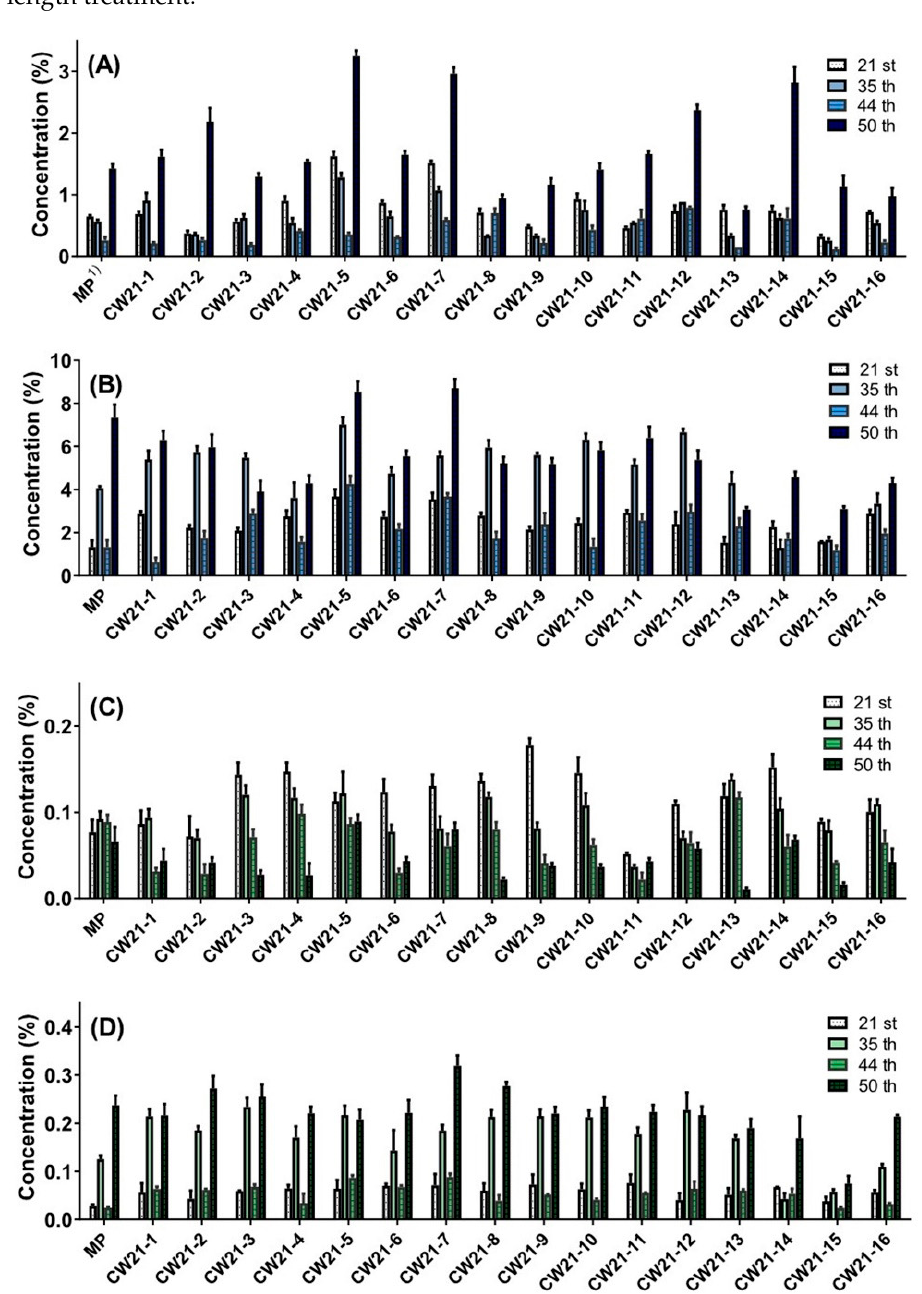
Figure 4. Cannabinoid content by strain and date. ( A ) CBD + CBDA of leaf, ( B ) CBD + CBDA of inflorescence, ( C ) ∆ 9-THC + 9-THCA of leaf, ( D ) ∆ 9-THC + ∆ 9-THCA of inflorescence. Indications of 21st–50th represent the days of short daylight treatment.